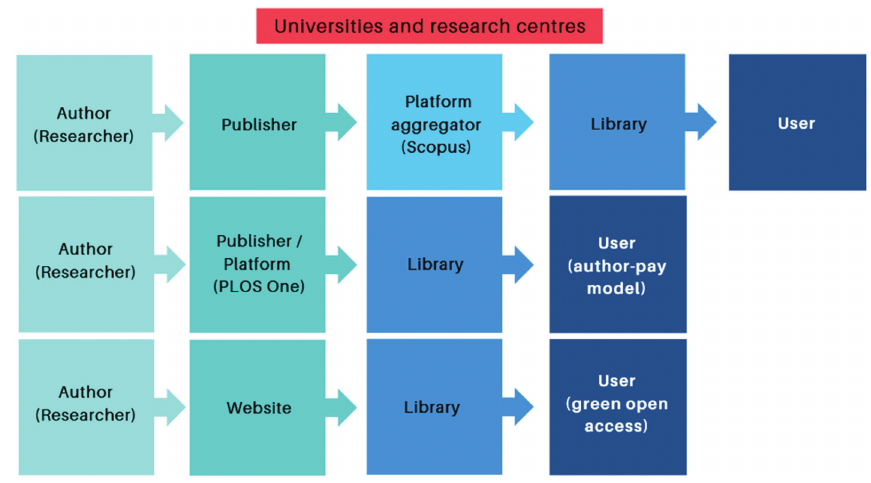
Fig. 4: Scholarly communication: Commercial and non-commercial Open Access